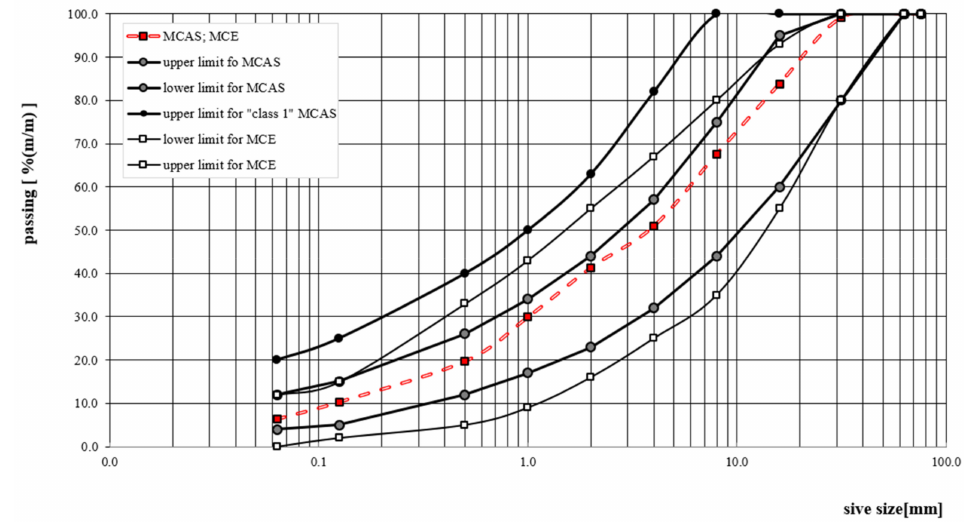
Figure 6. Gradation curve of the foamed bitumen (MCAS) / MCE cold-recycled